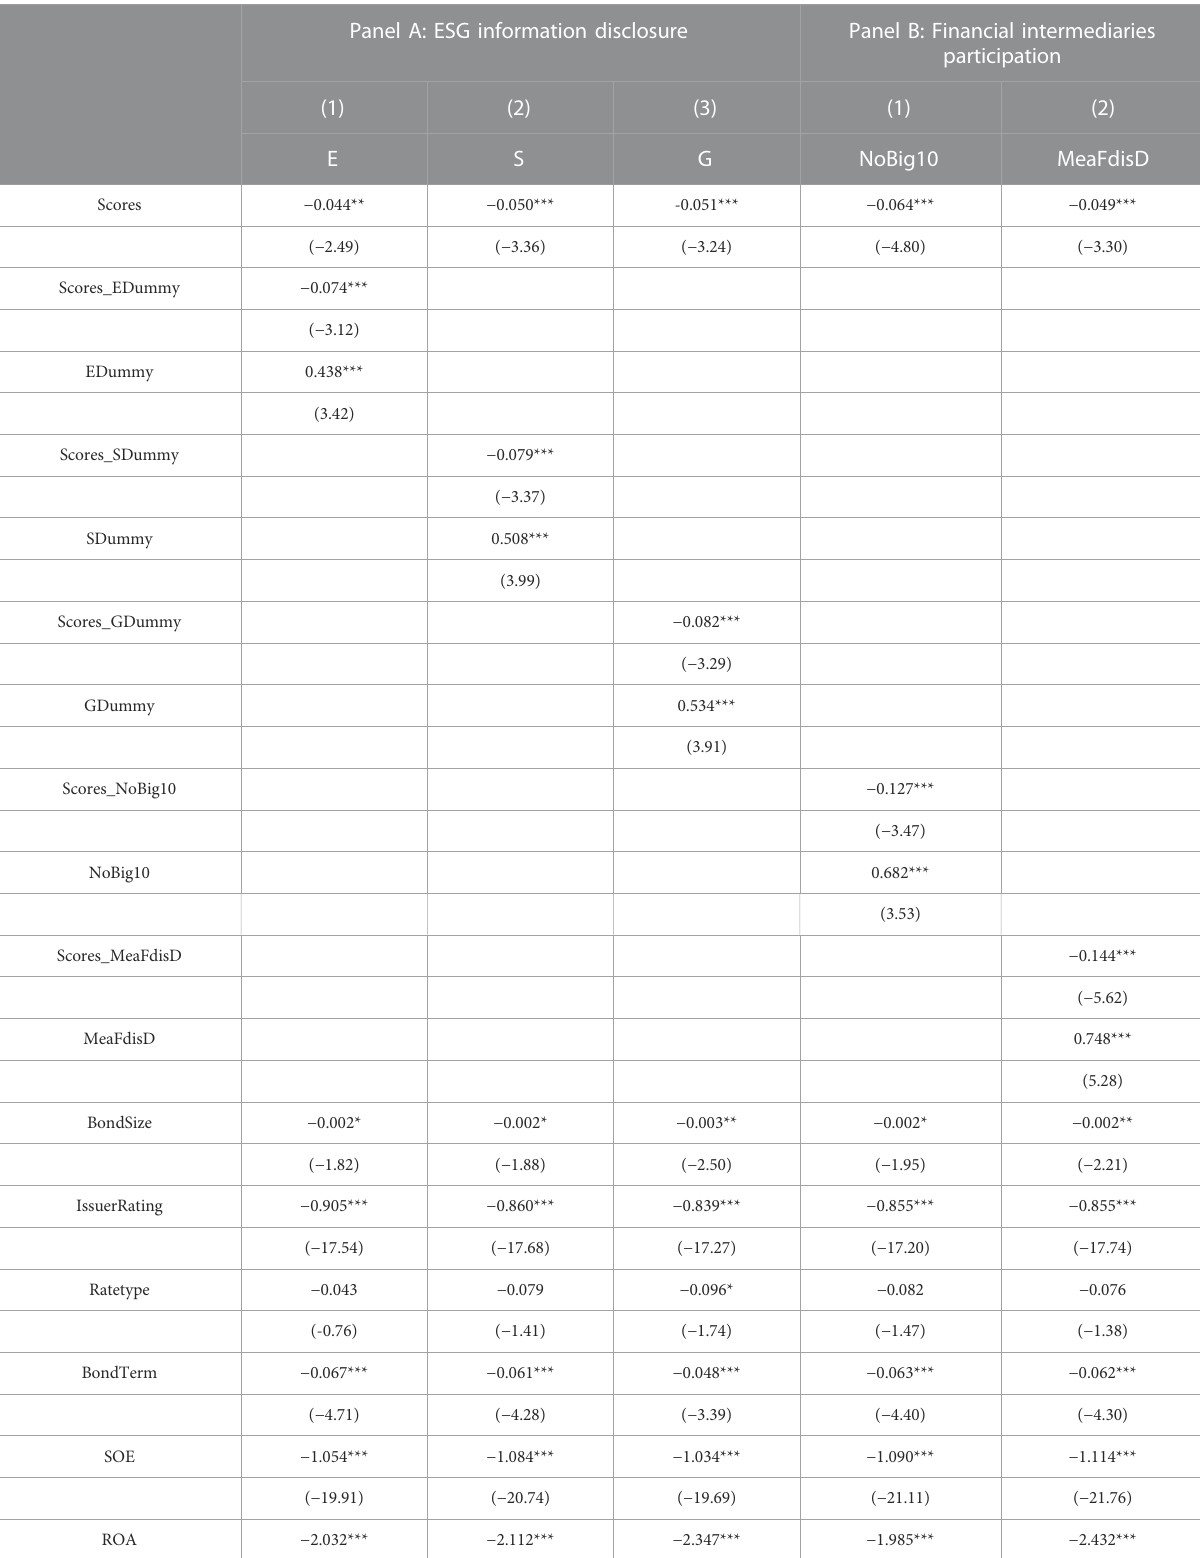
TABLE 6 Mechanism analysis. Panel A: ESG information disclosure Panel B: Financial intermediaries